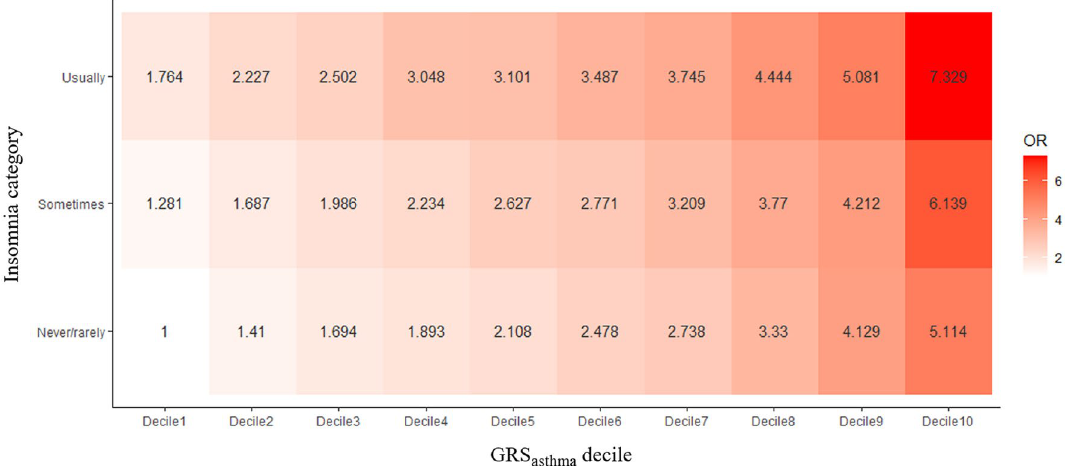
Figure 1. Odds ratio (OR) heatmap of asthma between GRS asthma and insomnia categories. The OR of asthma was compared on the basis of the OR of the subset with the lowest GRS asthma and ‘never/rarely’ category of insomnia, and adjusted with respect to age and sex. All subsets and reference subsets show significant differences in the OR (P < 0.05).